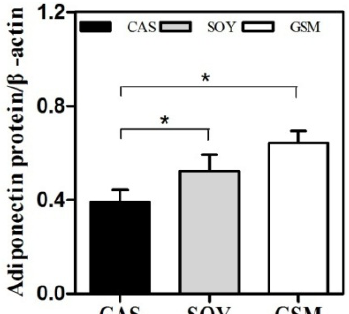
Figure 5. The effect of different dietary proteins on the expression of adiponectin protein in epididymal adipose tissue. Protein levels of adiponectin were normalized against that of β -actin (served as a loading control). One-way ANOVA followed by LSD-test was used to detect significant differences of the means, * p < 0.05.